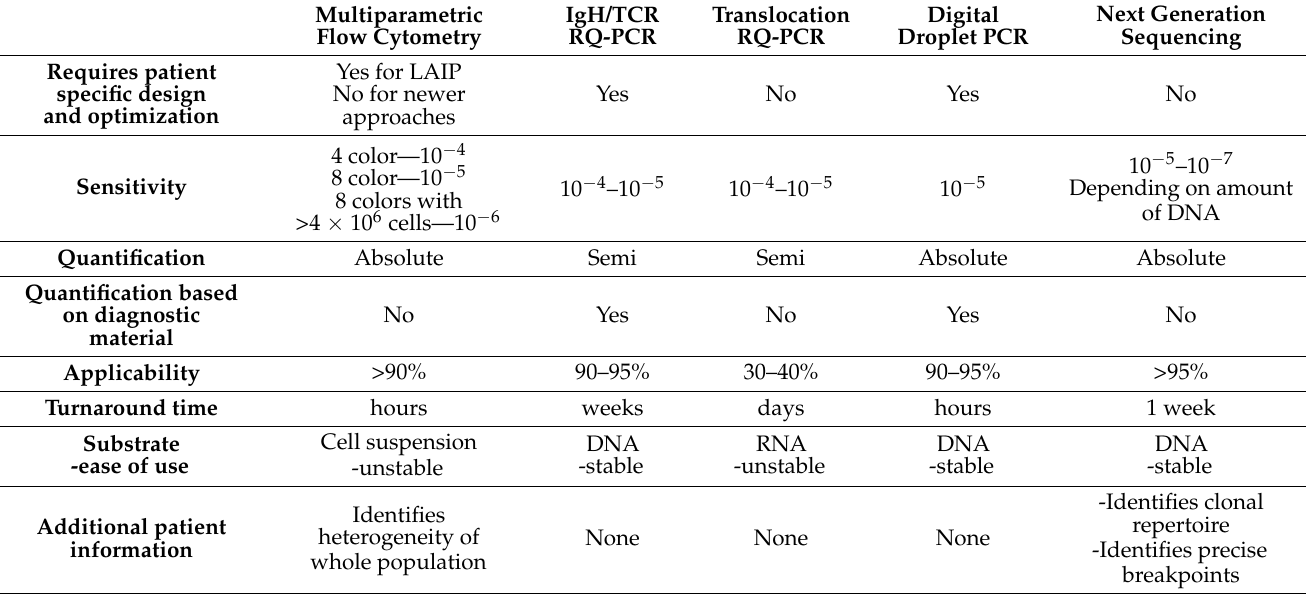
Table 1. Comparison of technical methods for minimal residue disease (MRD)